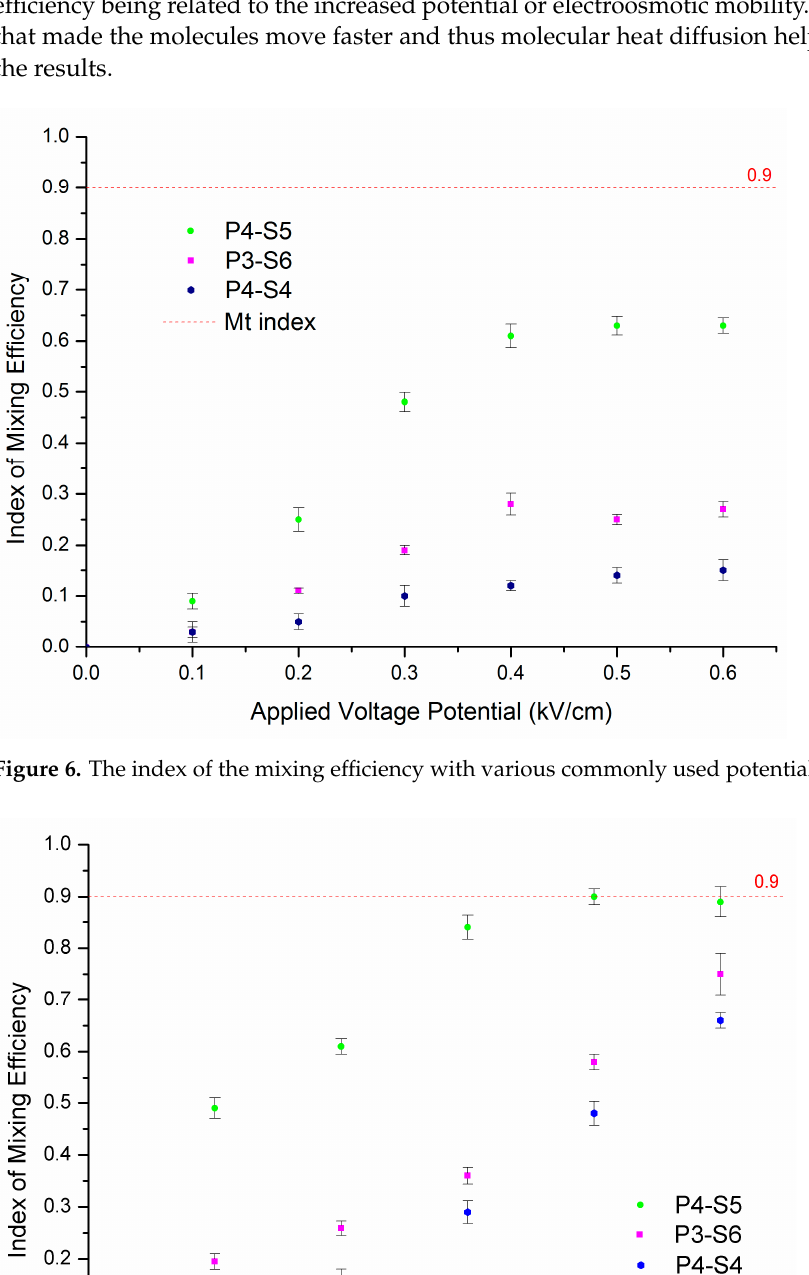
Figure 8. The index of the mixing efficiency with different lengths of the mixing channel.